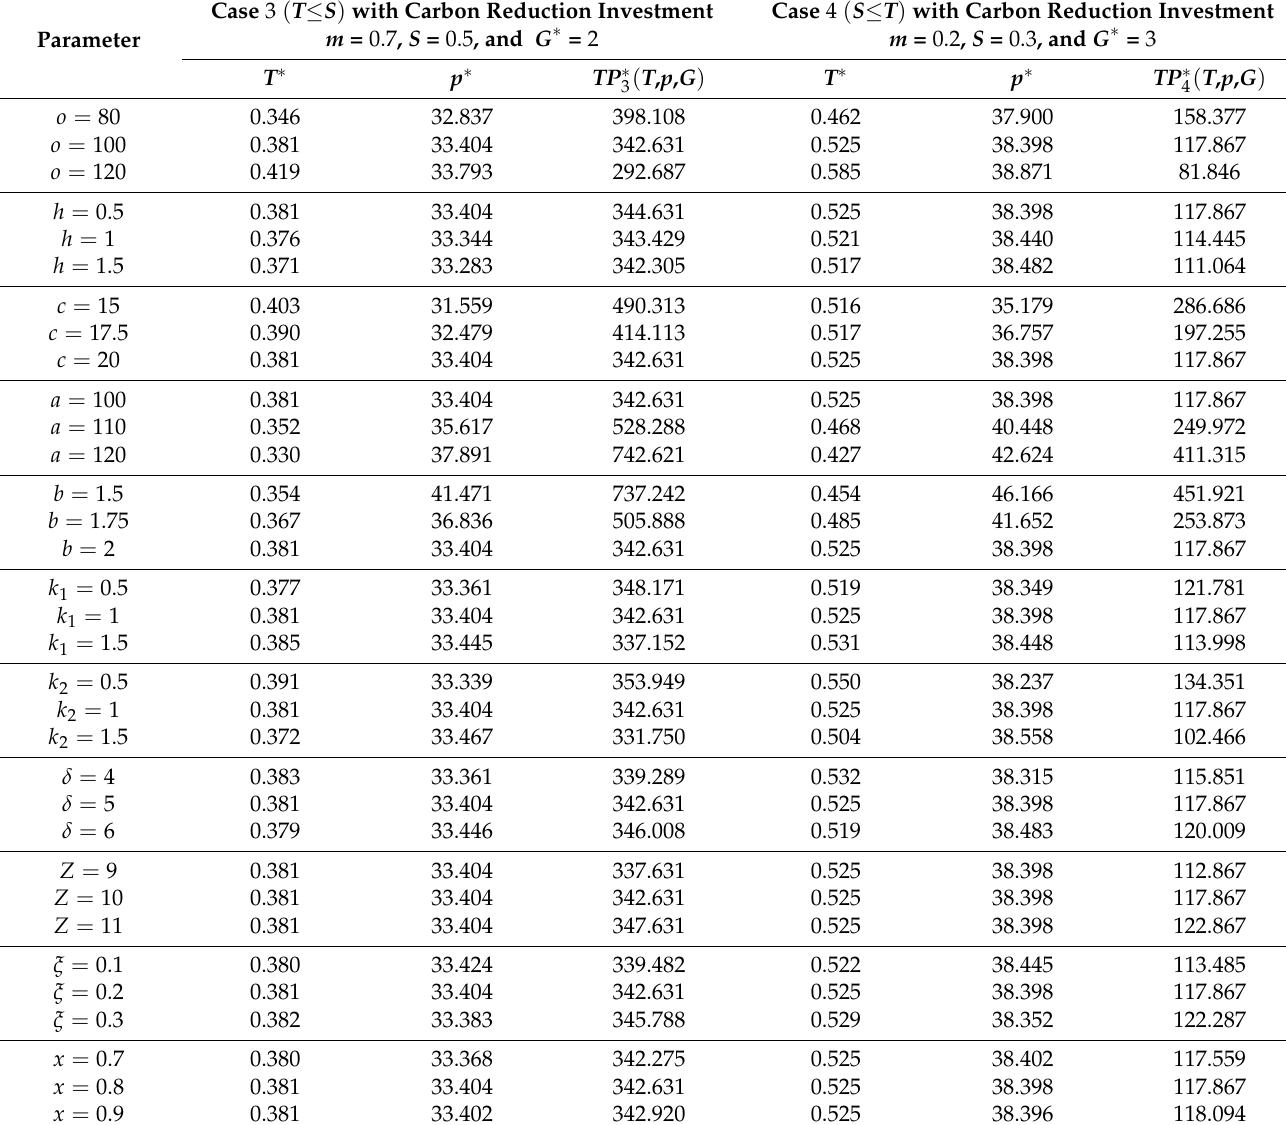
Table 6. Sensitivity analysis for the parameters for Cases 3 and